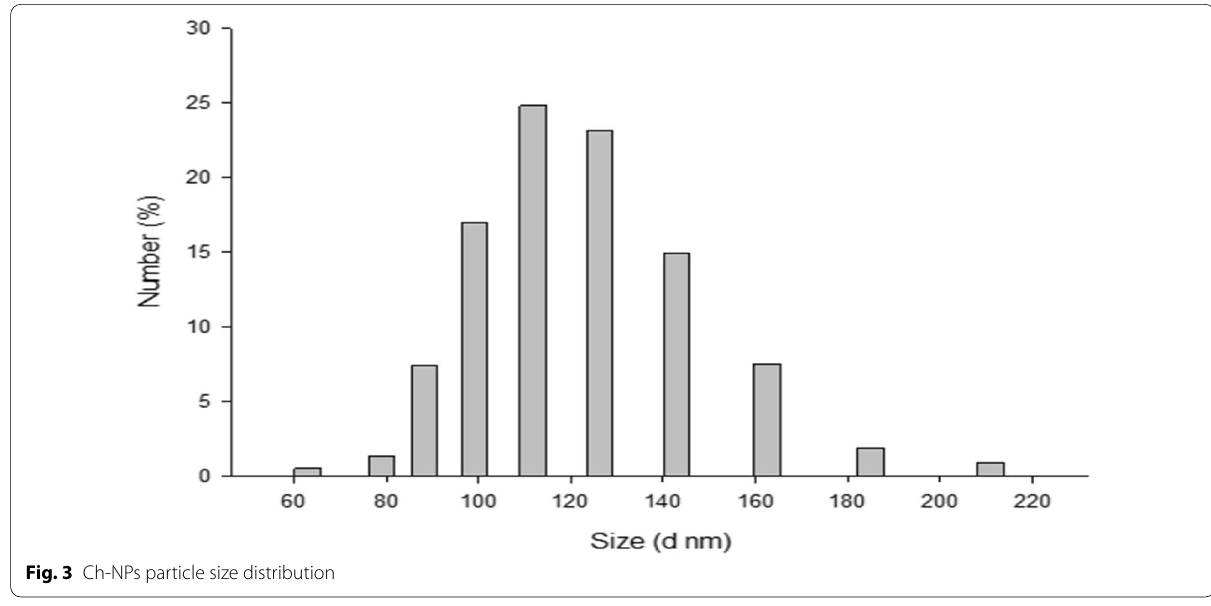
Fig. 3 Ch-NPs particle size distribution